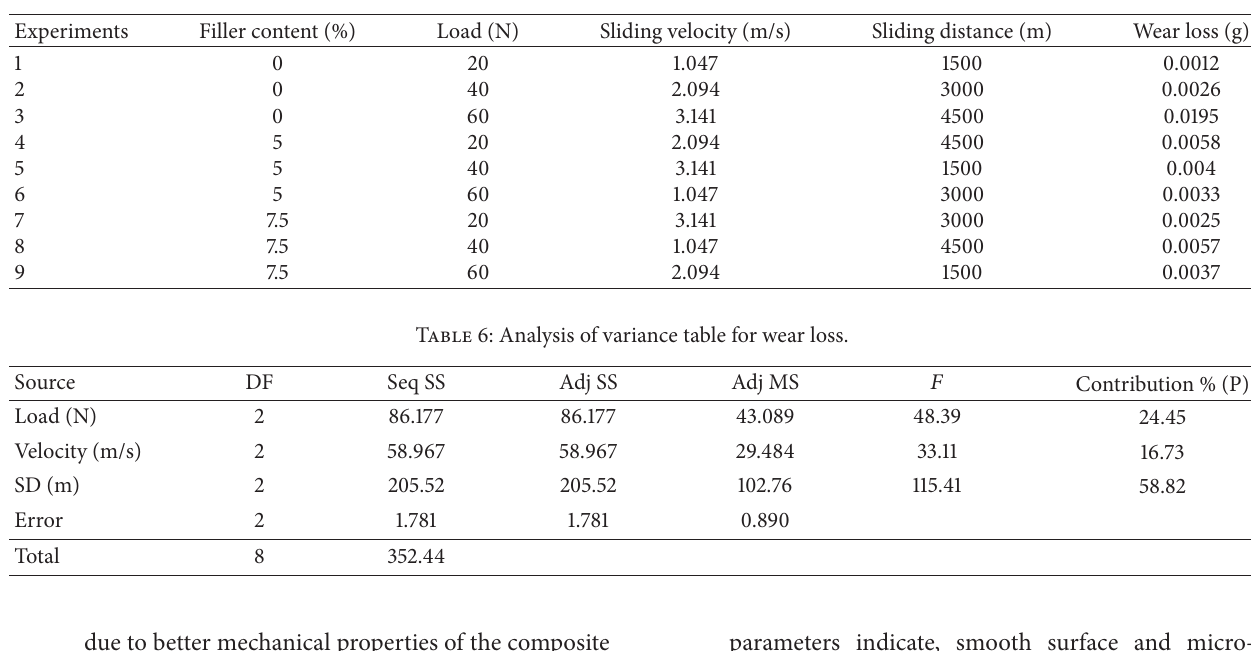
Figure 18: Main effect plot for signal-to-noise ratio. Table 5: Standard orthogonal L